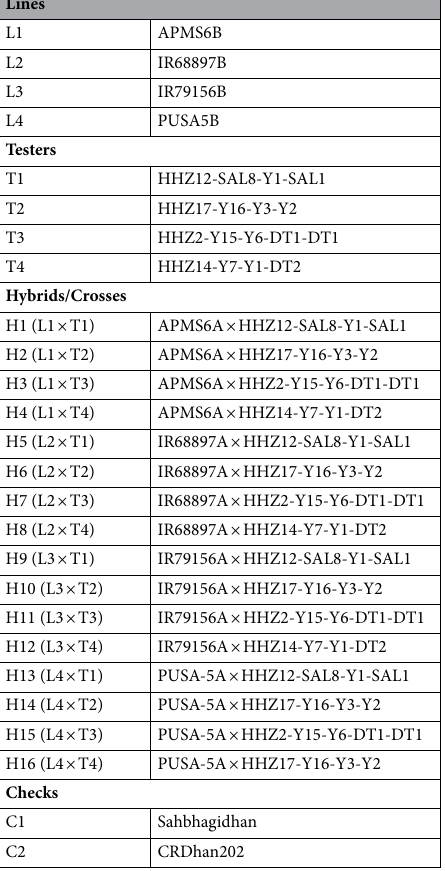
Table 1. Lines (L), Testers (T) and Hybrids (H) used in L × T mating design study in irrigated and aerobic environments.